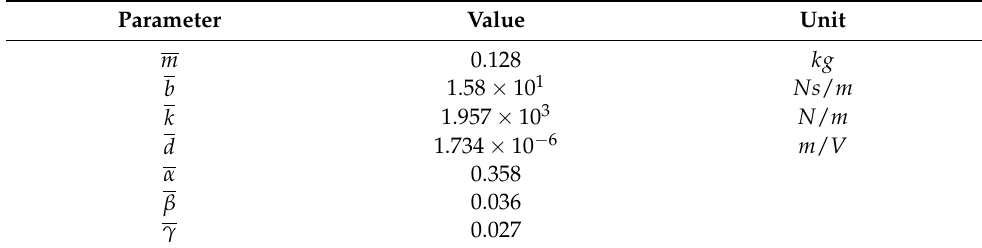
Table 1. Nominal parameters of the proposed micro-positioning actuator.